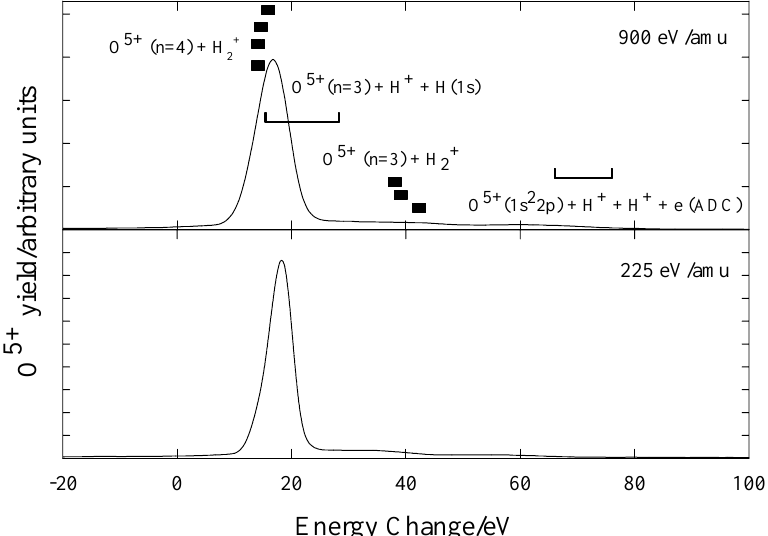
at 900 eV/amu and 225 2